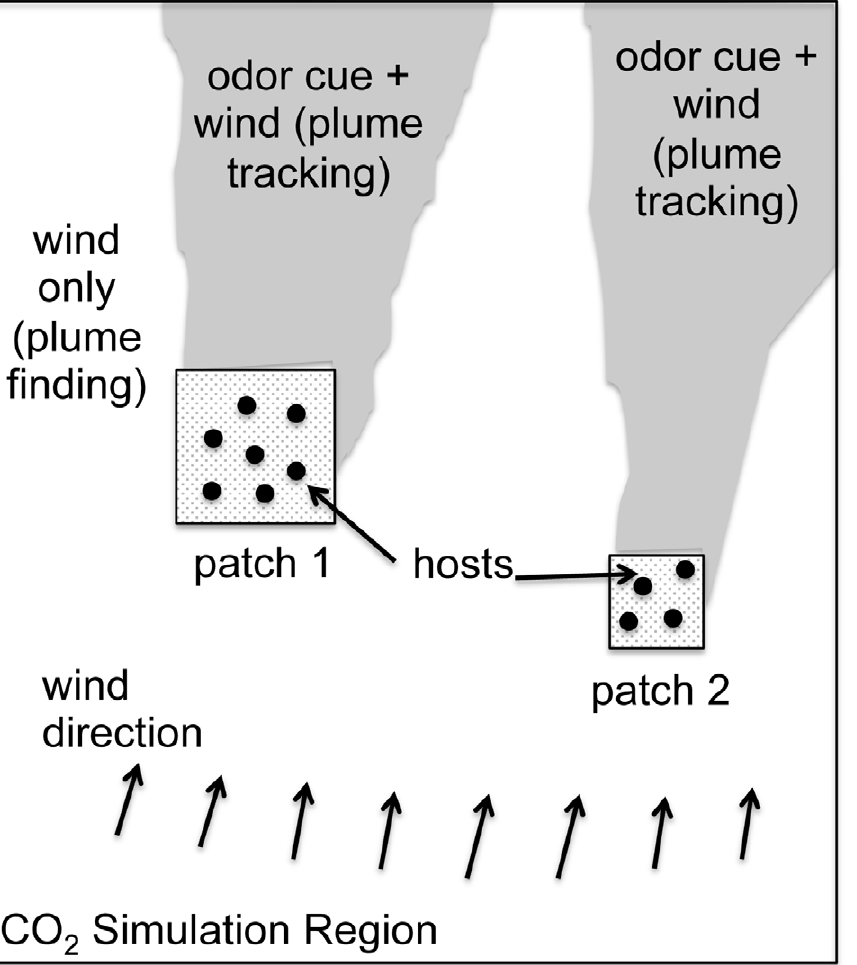
Figure 1. Computational domain. This is a schematic of the CO 2 simulation region where the odor plume is computed. At the edges of the simulation region, the CO 2 concentration is carried out by the wind. The patches represent smaller subregions where the hosts are located. The spatial distribution of hosts within each patch is uniform and there can be multiple patches. The hosts are stationary in the following simulations, although this is not a limitation of the model. The mosquitoes are initially placed in a subregion inside the CO 2 simulation region but are allowed to leave it (and possibly reenter it) during the simulation. The wind exists everywhere, even outside the CO 2 simulation region.